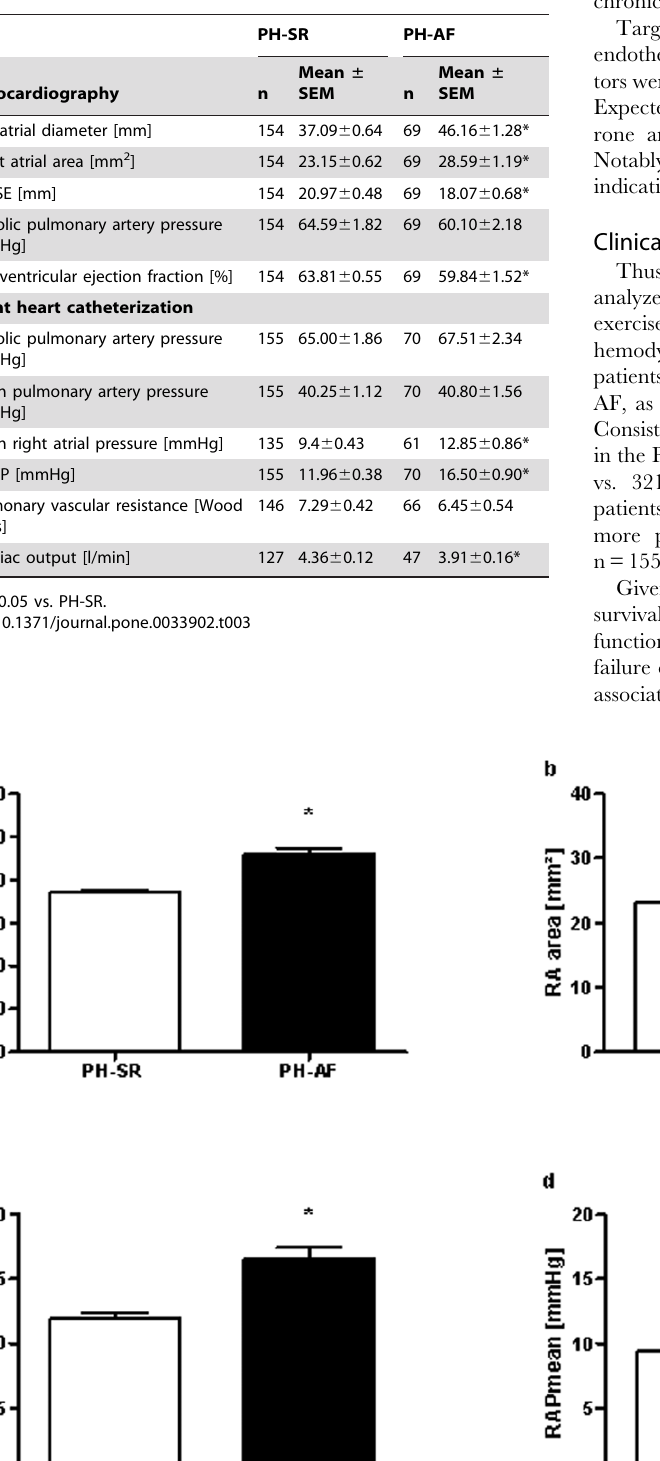
Table 3. Effect of AF on hemodynamic parameters in PH.